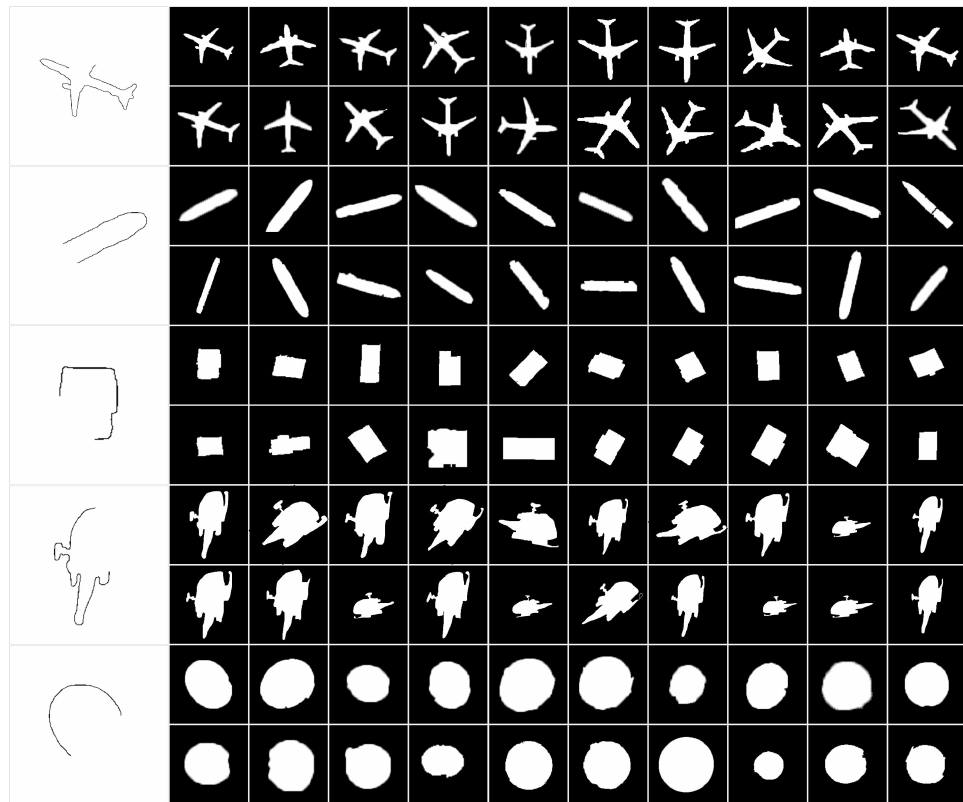
Figure 9. The leftmost column is a schematic diagram of the target shapes artificially occluded (to verify the effectiveness of the proposed method in the shape recognition stage), and the remaining part is 100 single remote sensing target shapes collected from the internet and remote sensing image databases.